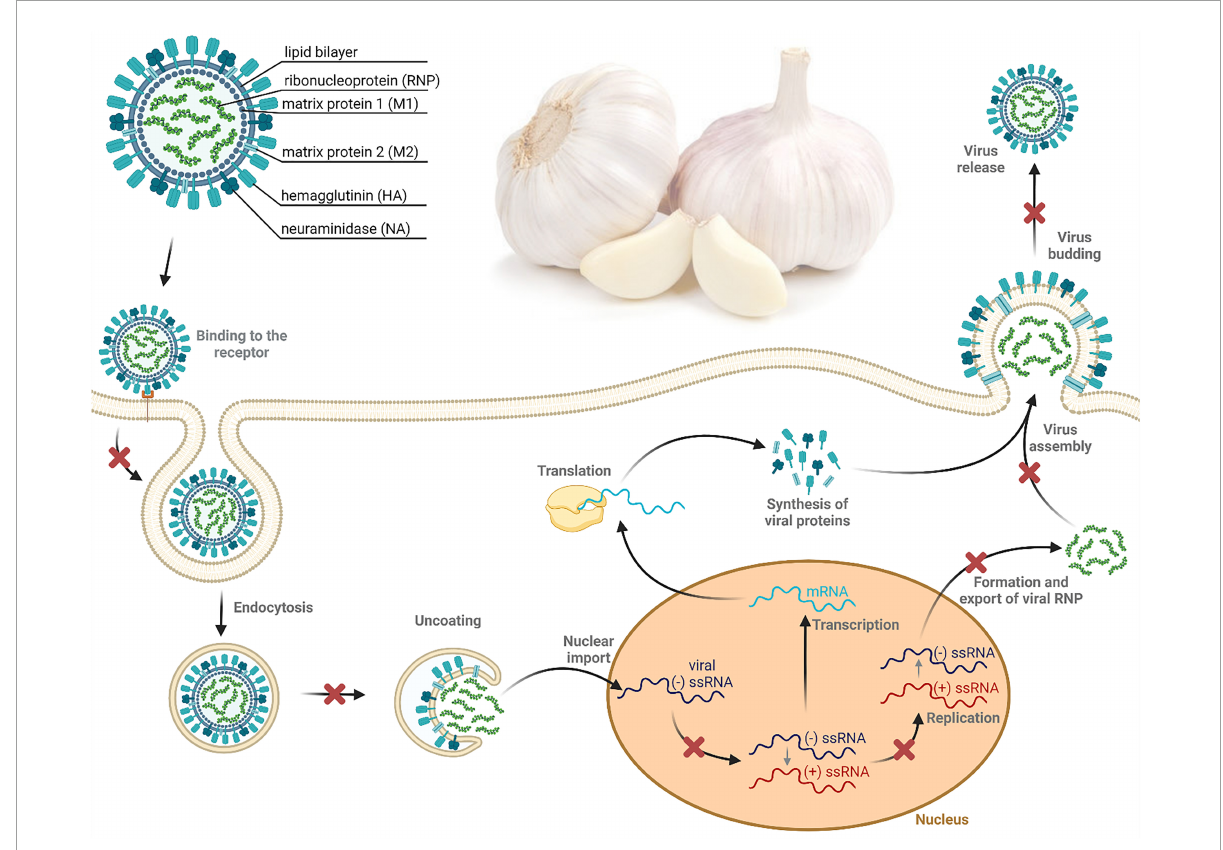
FIGURE4 Proposed antiviral effects of A. sativum against (–) ssRNA viruses. This figure depicts the life cycle steps of influenza A with possible inhibition (shown as a red X-shaped symbol) mediated by garlic extracts or its organosulfur constituents. As shown in the figure, A. sativum bears potential for the prevention of viral penetration into the host membrane, virus uncoating associated with the release of viral genetic material into the cytoplasm, conversion of viral (–) ssRNA to viral (+) ssRNA, replication of the viral RNA, virus assembly and release (3). Figure made using